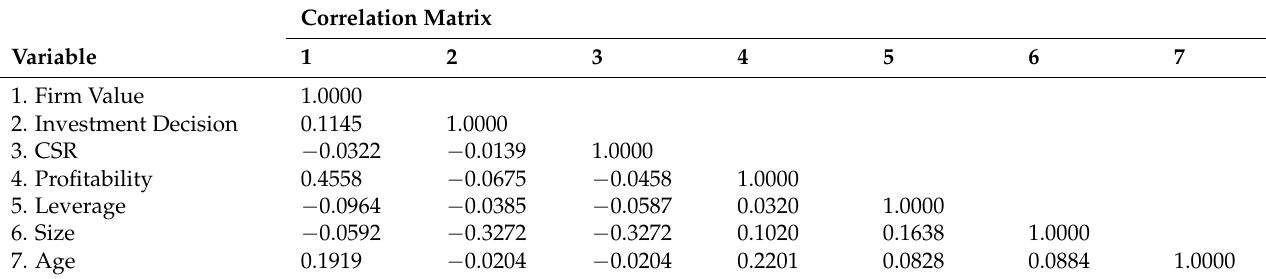
Table 3. Correlation